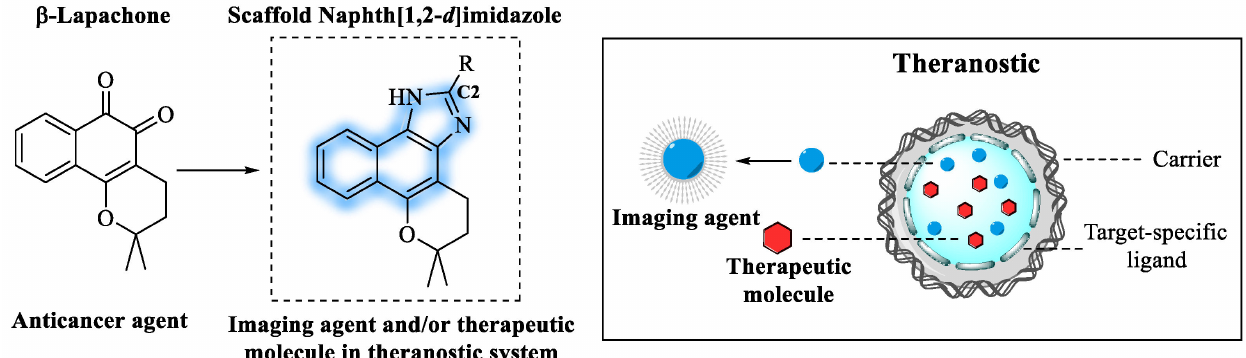
Figure 1. Molecular design of the naphth[1,2- d ]imidazoles with anticancer and fluorescent